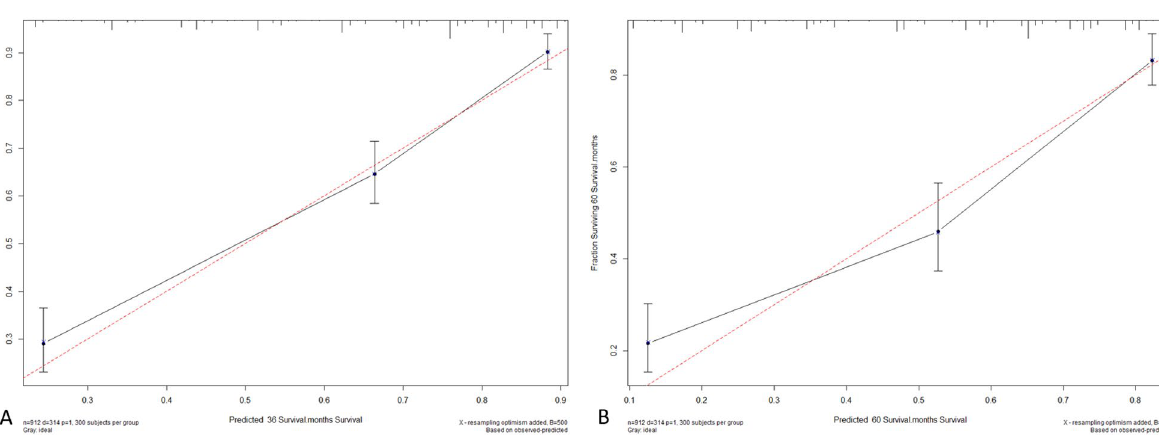
Figure 4. 3- ( A ) and 5-years ( B ) calibration curves for probability of HCC patient CSS nomogram construction in validation cohort (bootstrap = 500